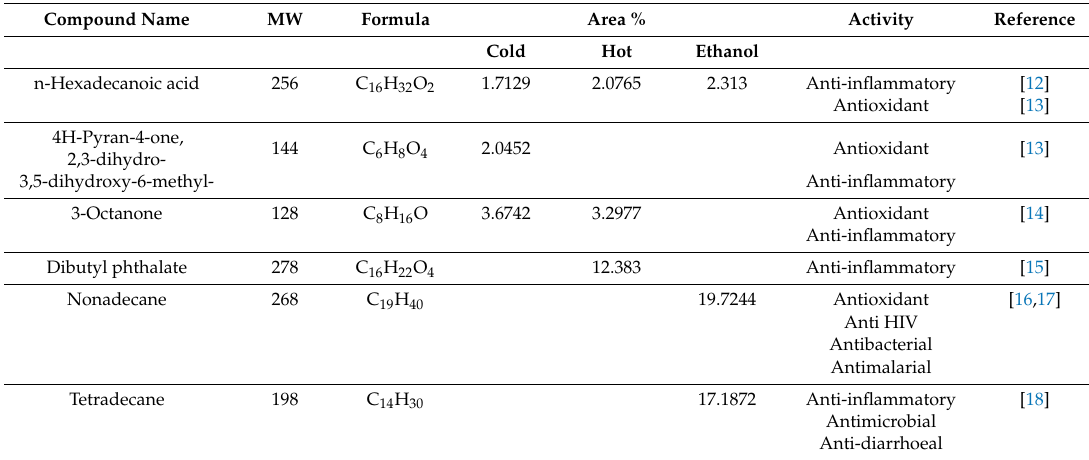
Table 2. Compounds identified in the cold-water, hot-water and 70% ethanol extracts of P. natalensis mushroom with antioxidant and anti-inflammatory